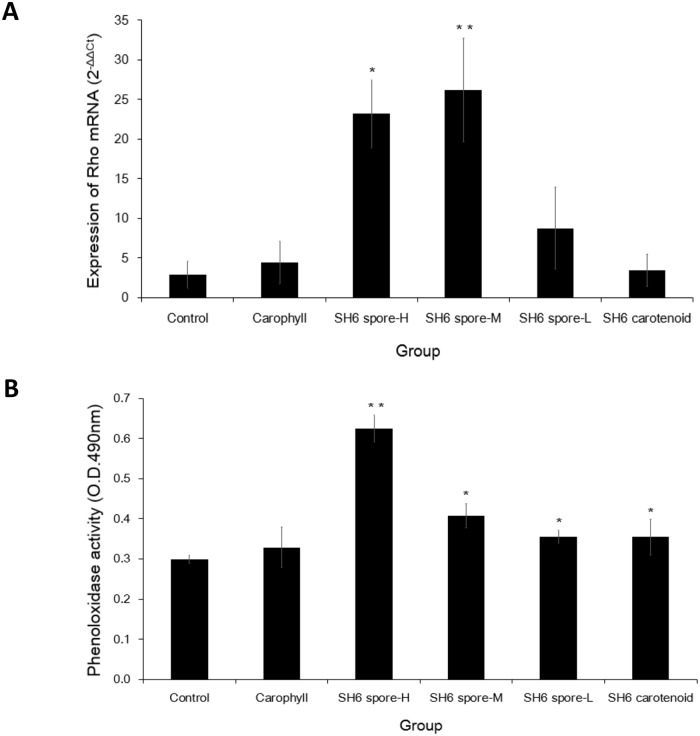
Rho mRNA expression and Phenoloxidase activity of L. vannamei after 28 d feeding with SH6 spores.Experiment includes negative control, Carophyll (astaxanthin: 0.5 mg/g pellet), SH6 carotenoid (SH6 carotenoids: 5 μg/g pellet), and SH6 spore-H/M/L groups (SH6 spores at 5 × 106, 1 × 106, 2 × 105 CFU/g pellet, respectively). (A) Gene expression level of Rho (Ras-like protein) gene is indicated by 2-ΔΔCt value. (B) Phenoloxidase (PO) activity is indicated by OD490nm. Data are presented as arithmetic means and error bars are standard deviations (n = 3). P values were generated using Student’s t-test for multiple comparisons to the control (*P <0.05; **P <0.01).